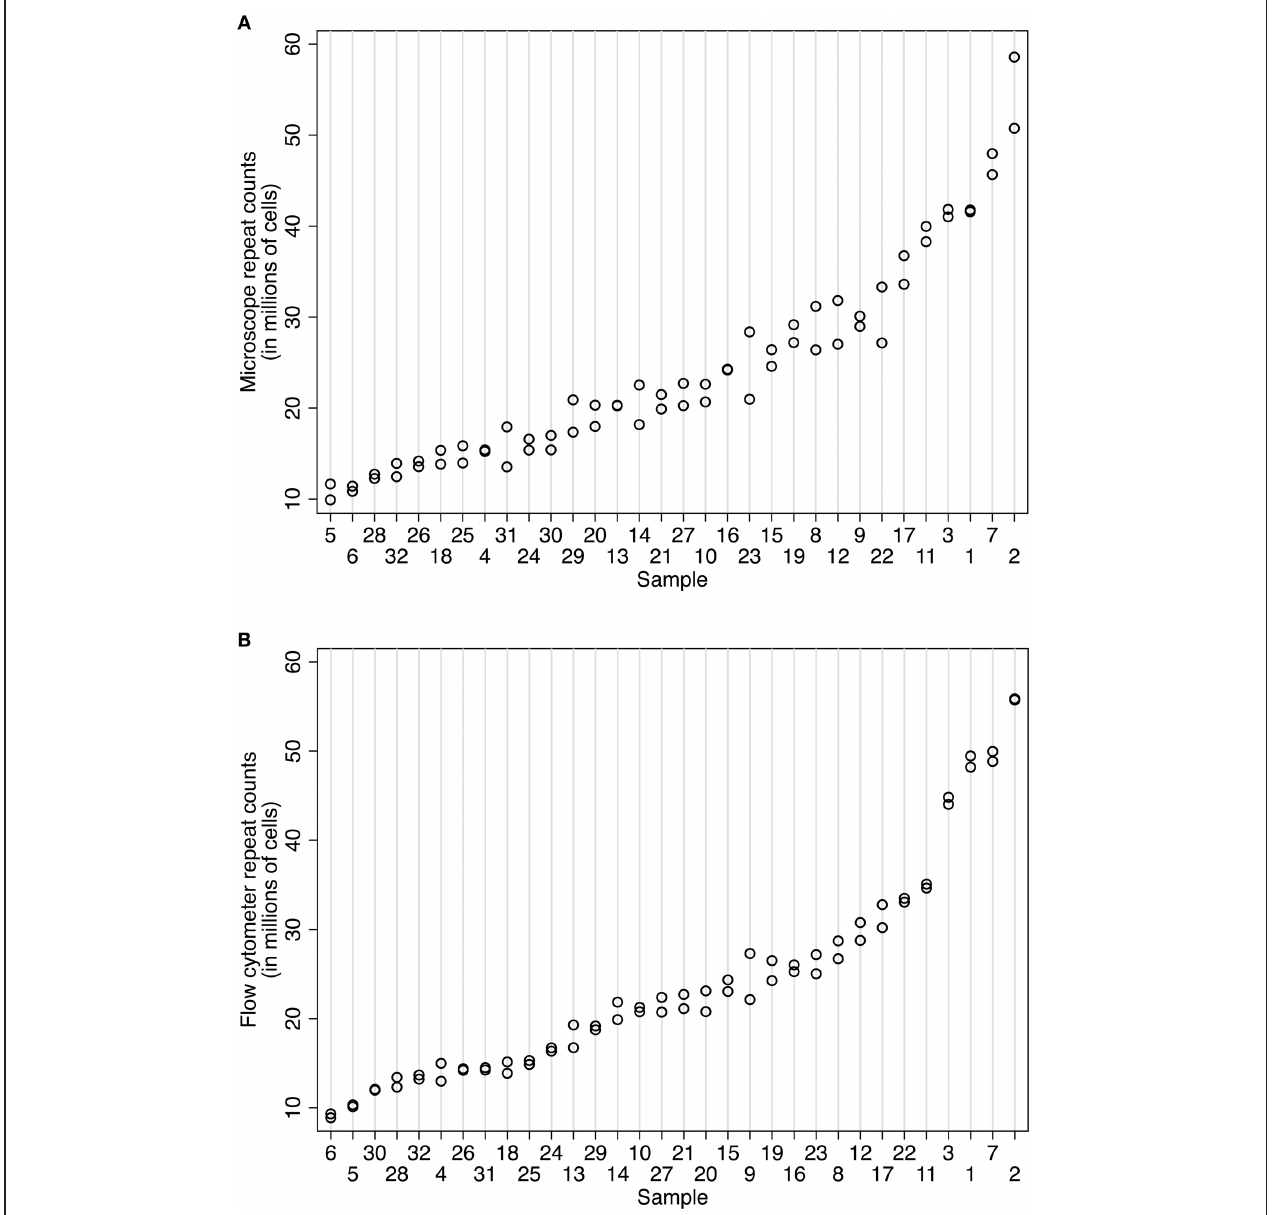
FIGURE 3 | Comparison of repeatability measures using (A) the isotropic fractionator and (B) the flow fractionator. In both panels, the samples are organized along the x-axis by increasing mean cell density. The number of nuclei counted in a sample is indicated on the y-axis. Each count is represented by one circle. The same aliquot was counted at least twice to isolate error associated with repeat counting from the same sample (i.e., counting error). Two sets of 32 samples from case 11-31 were prepared